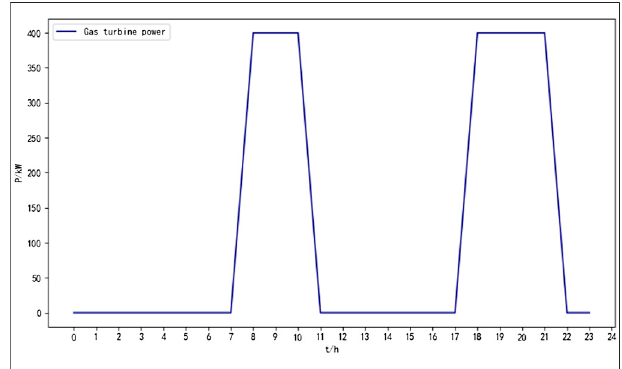
FIGURE 7 | Gas turbine output curve.